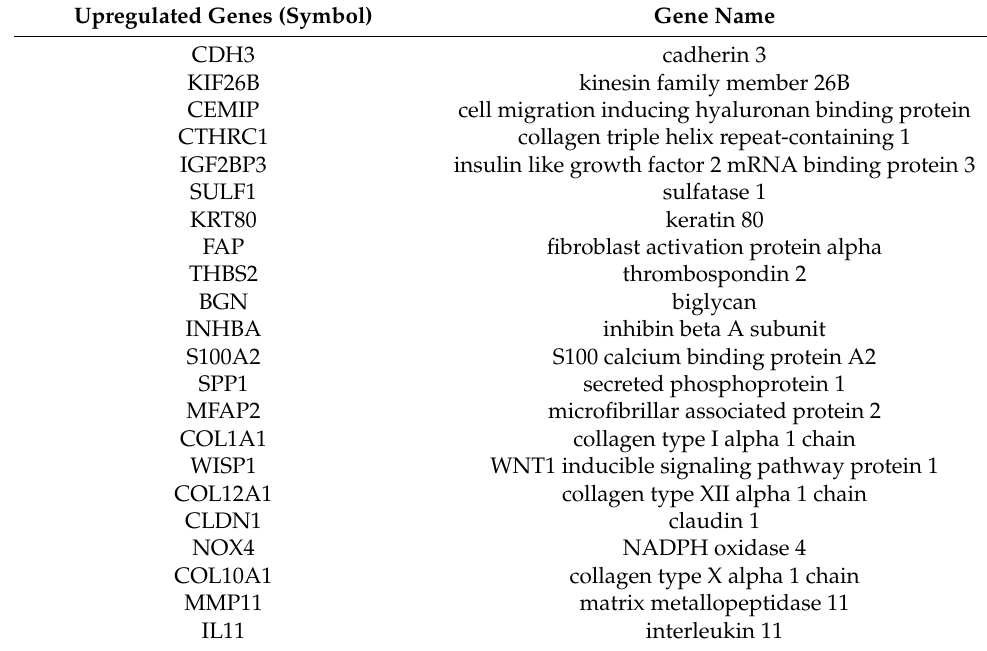
Figure 1. Venn diagrams of upregulated and downregulated genes in all three GC microarray datasets. Table 1. Common upregulated and downregulated genes.